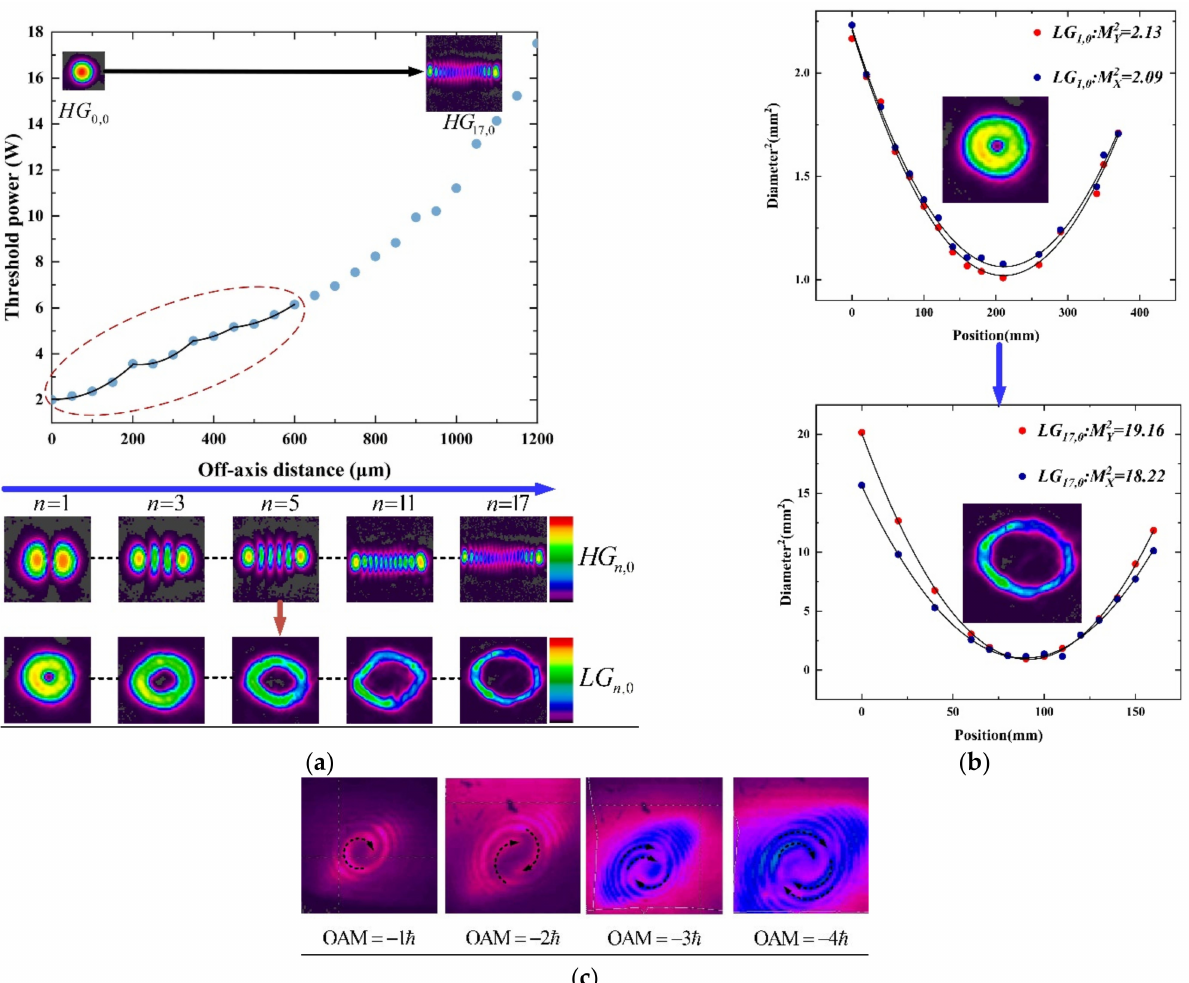
Figure 3. ( a ) Threshold power of the laser during off-axis processes and measured HG n,0 modes and LG n,0 modes. ( b ) Beam quality of LG modes. ( c ) The interference pattern of the vortex beam with the spherical